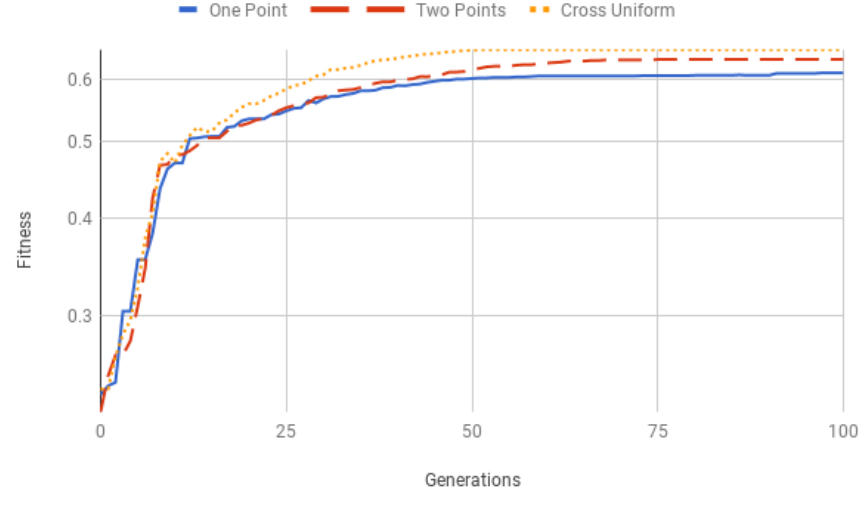
Figure 7. Maximum fitness values for different crossover techniques with an initial population of 2000.